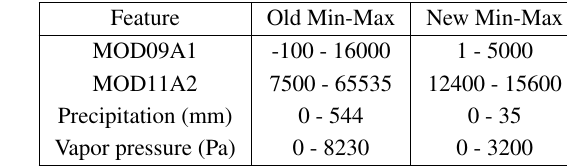
Table 3. Theoretical and calculated ranges for input